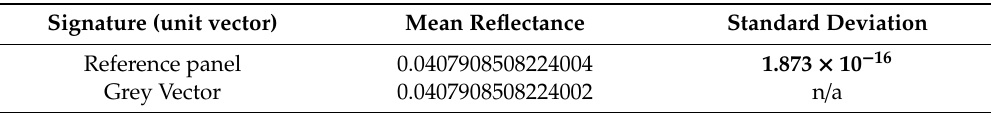
Table 3. Statistical comparison of normalised reflectance signatures from the reference panel and a normalised theoretical grey vector. Mean reflectance is the mean of all reflectance values between 400–1000